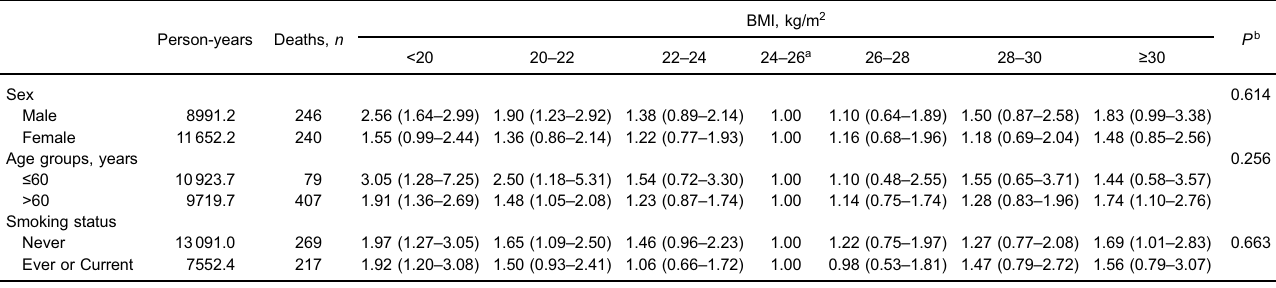
Figure. Predicted all-cause and CVD mortality with 95% con fi dence intervals based on the best fi tting fractional polynomial models in the total participants (Figure 1: all-cause mortality; Figure 2: CVD mortality) and after excluding those who were censored during the fi rst 2 years of follow-up (Figure 3: all-cause mortality; Figure 4: CVD Table 4. Hazard ratio of all-cause mortality according to di ff erent levels of BMI among patients with hypertension of various subpopulations